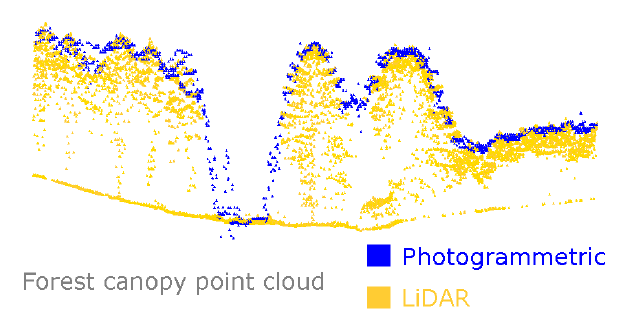
Figure 5. Comparison between photogrammetric and LiDAR point clouds. LiDAR pulses penetrate the forest canopy and better account for small gaps and peaks, than the photogrammetric point cloud.